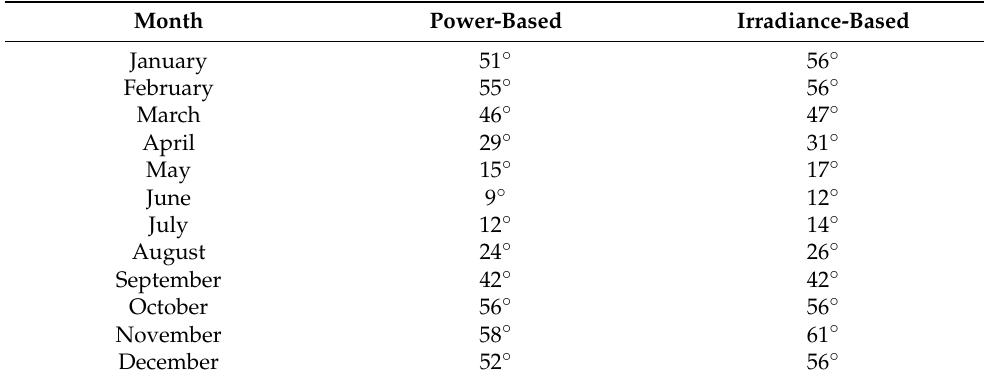
Figure 12. Optimization result and optimal tilt angle for different time interval. Table 3. Optimal tilt angle of power-based and irradiance-based monthly optimization.